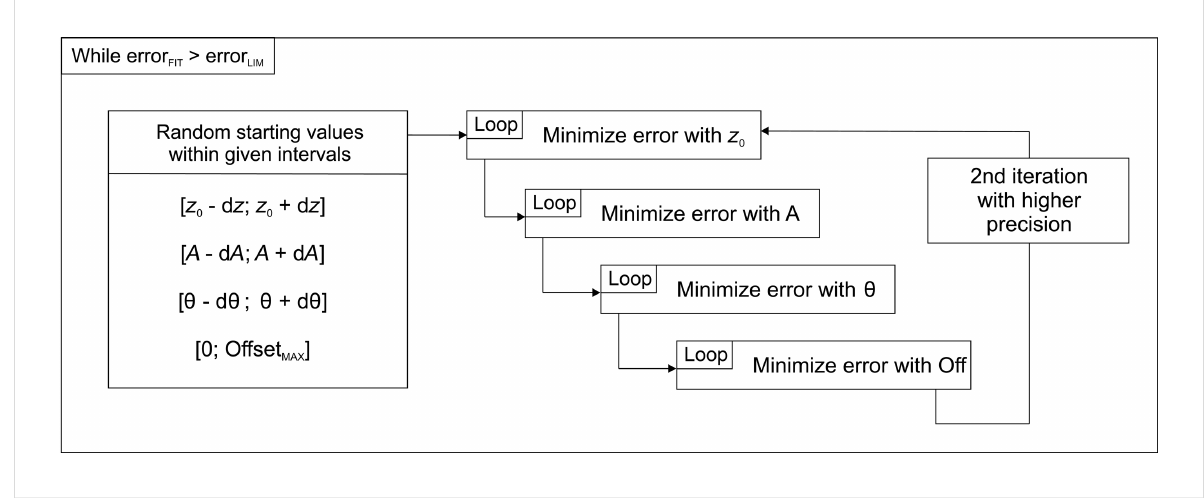
Figure 5: Structure of the fitting algorithm to avoid a local minimum. Random starting values within definable interval are used to start the first itera- tion to minimize the least squares error for z 0 , A , θ , and “offset” until the total error e FIT < e LIM .